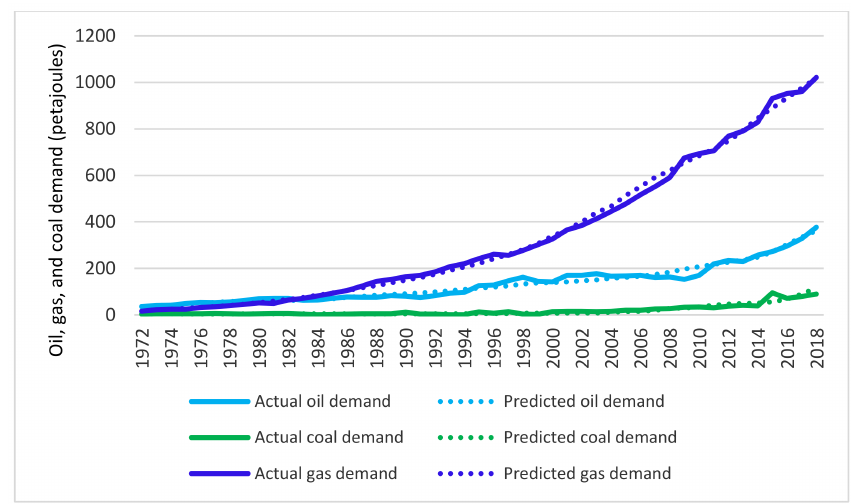
Figure 5. Comparison of actual vs. predicted oil, coal, and gas demand (petajoules).